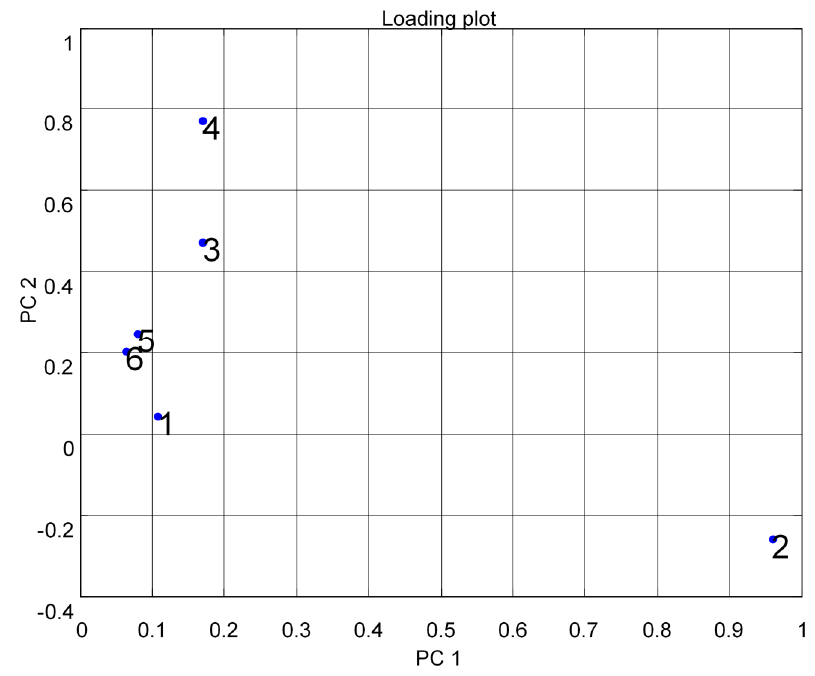
Figure 10. Multivariate technique on organic gases relative feature loading design.